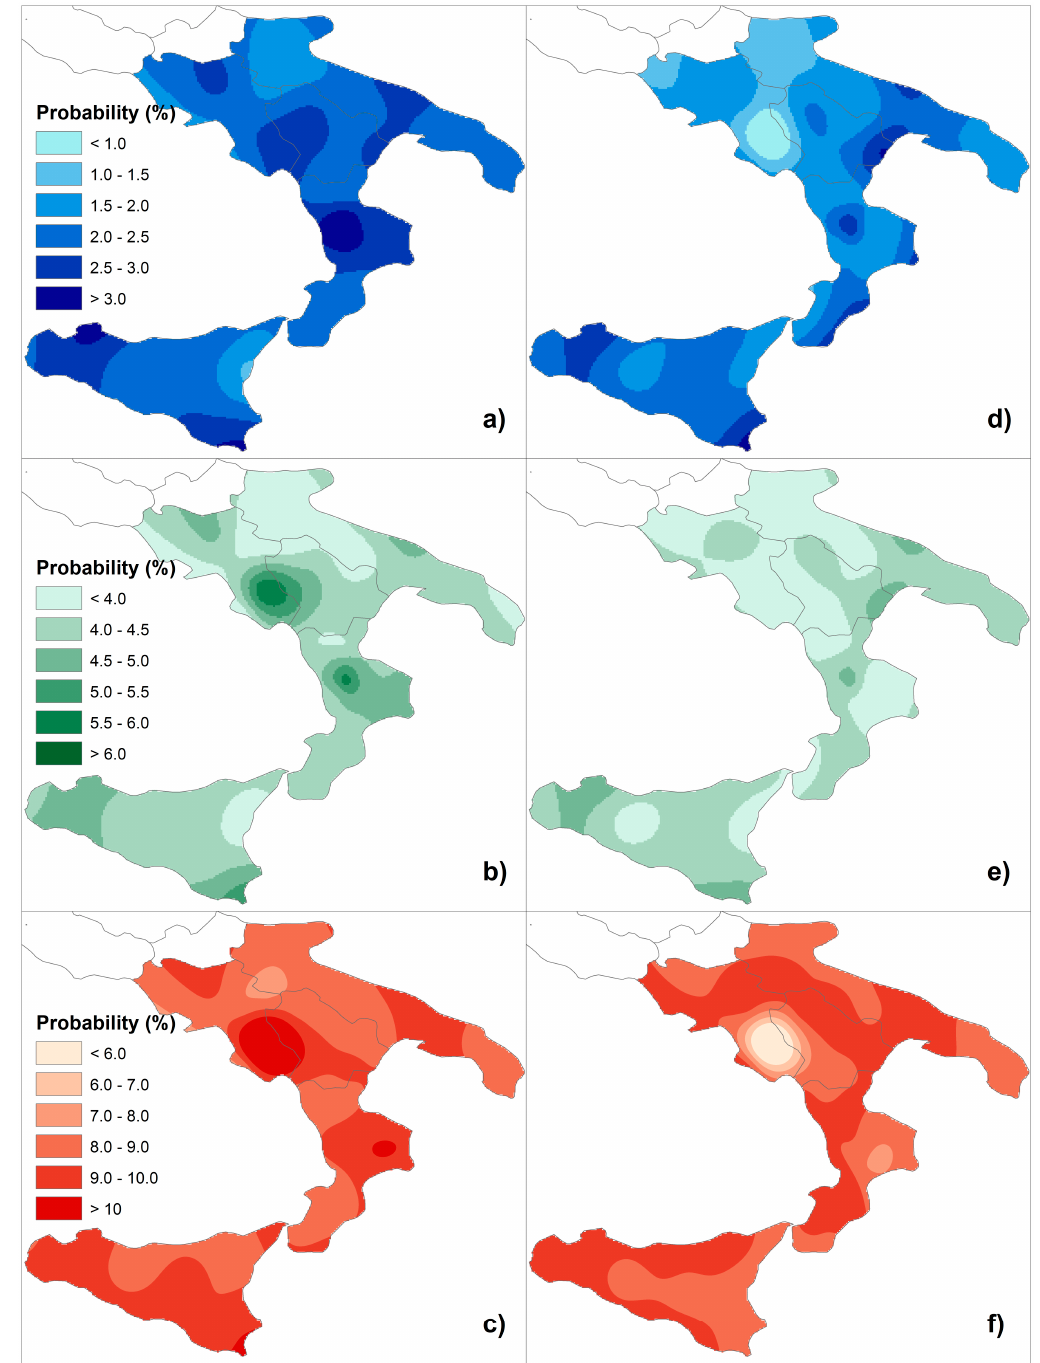
Figure 4. Maps of the monthly occurrence probabilities of Extreme drought ( a ), Severe drought ( b ), Moderate drought ( c ), Extremely wet ( d ), Severely wet ( e ) and Moderately wet ( f ) conditions for the 6-month SPI.